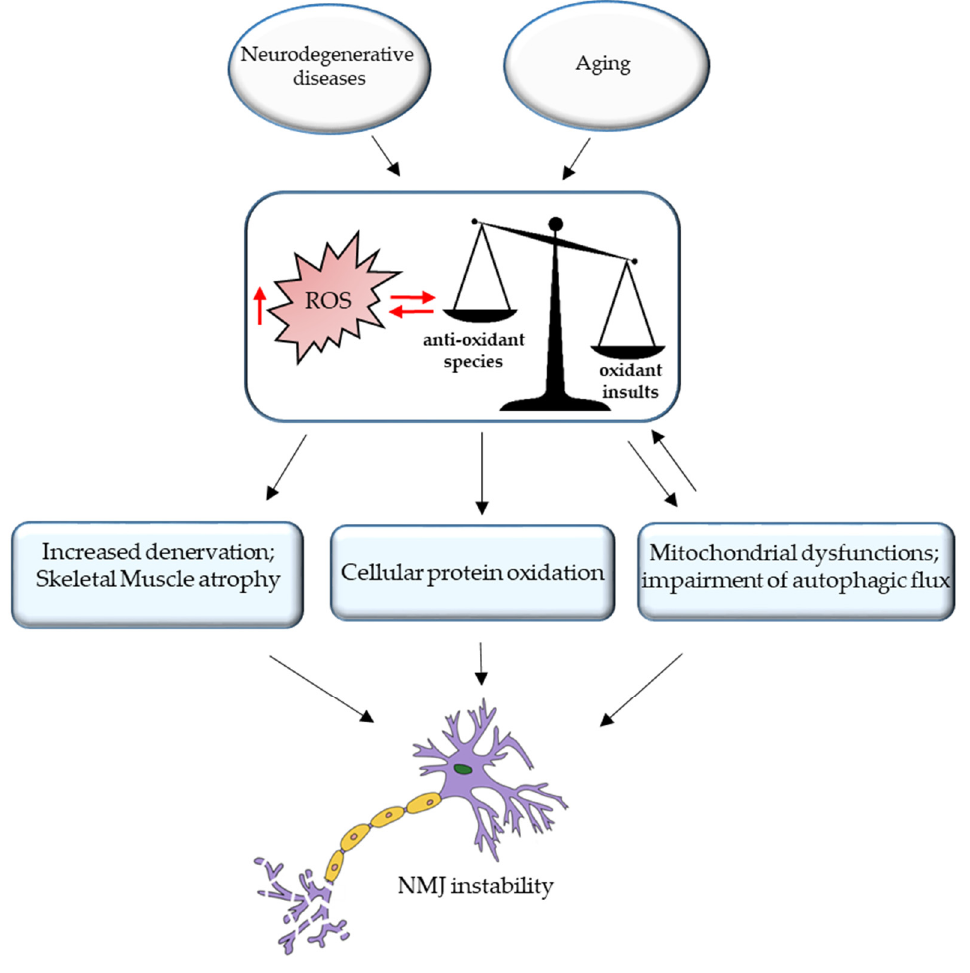
Figure 2. Oxidative stress and NMJ instability. Excessive ROS production during aging or neu- rodegenerative disorder is responsible for the increased denervation and skeletal muscle atrophy, cellular protein oxidation, mitochondrial dysfunction, and impairment of autophagic flux, leading to NMJ instability.